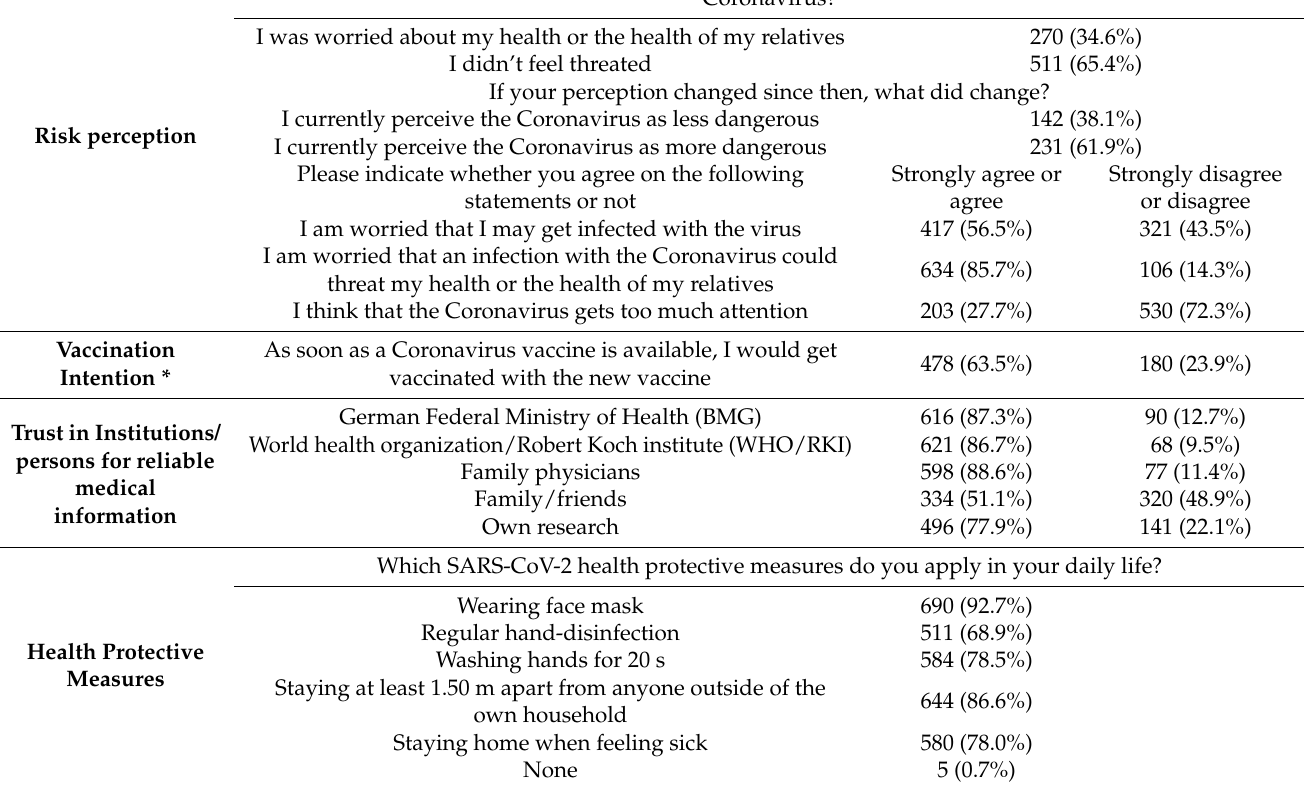
Table 2. Risk perception, vaccination intention, trust in health authorities, and health protective measures among all